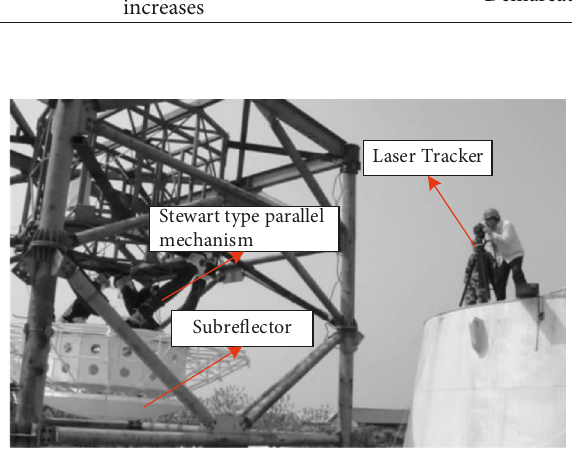
Figure 1: TM 65m subreflector attitude